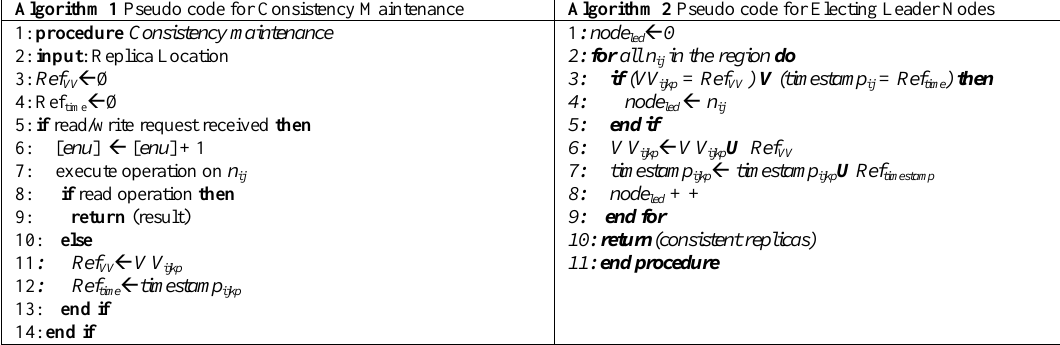
Algorithm 1 Pseudo code for Consistency Maintenance Algorithm 2 Pseudo code for Electing Leader Nodes 1: procedure Consistency